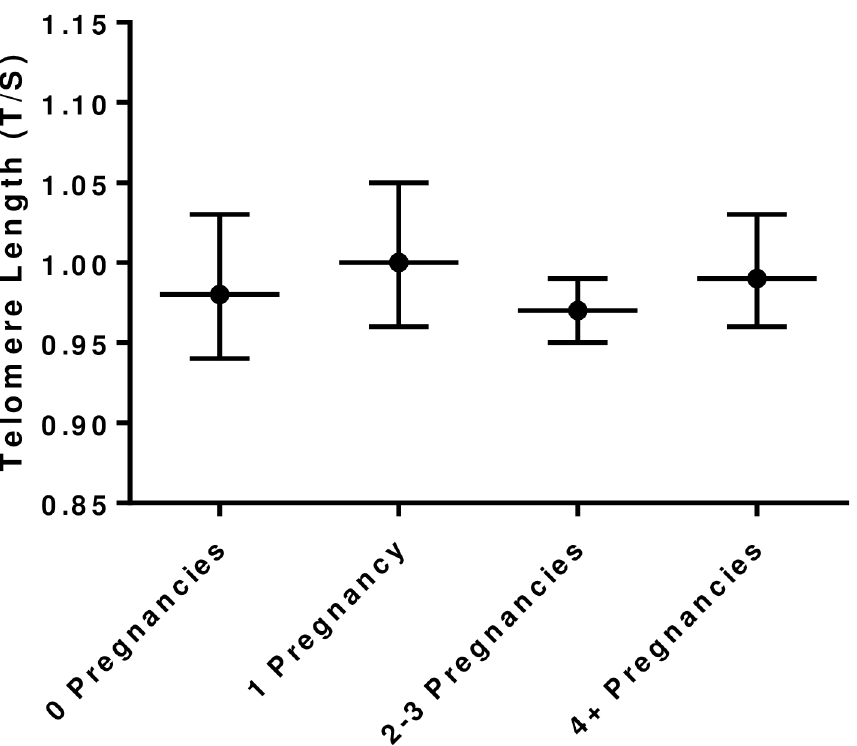
Fig 1. Telomere length (mean and 95% CI) by gravidity group. There were no differencesin unadjusted telomerelength betweengraviditygroups.